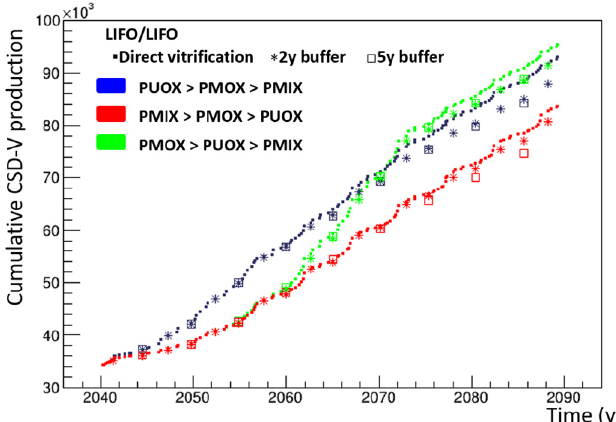
Fig. 14. Impact of time